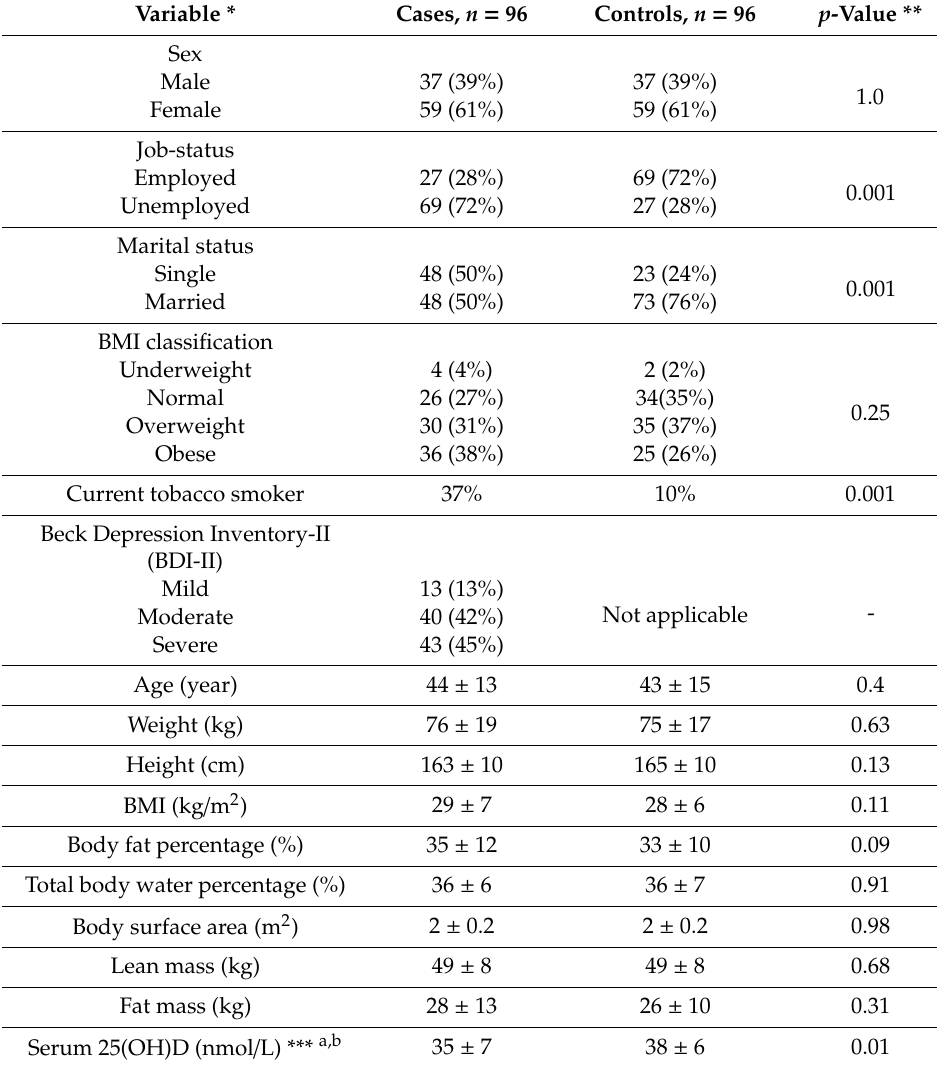
Table 1. Sociodemographic and anthropometric characteristics of the study participants. Variable